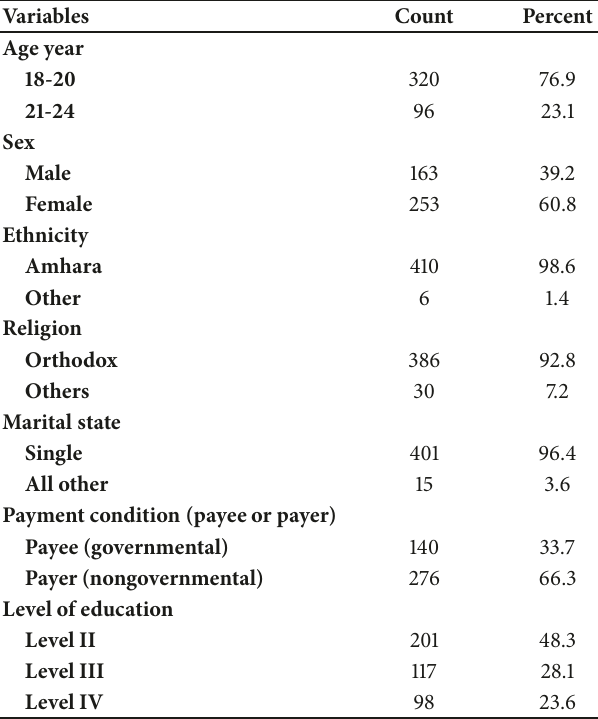
Table 2: Sociodemographic characteristics and some variables of theparticipantsamongDebreBirhangovernmentalandnongovern- mental health science colleges, Debre Birhan, 2016